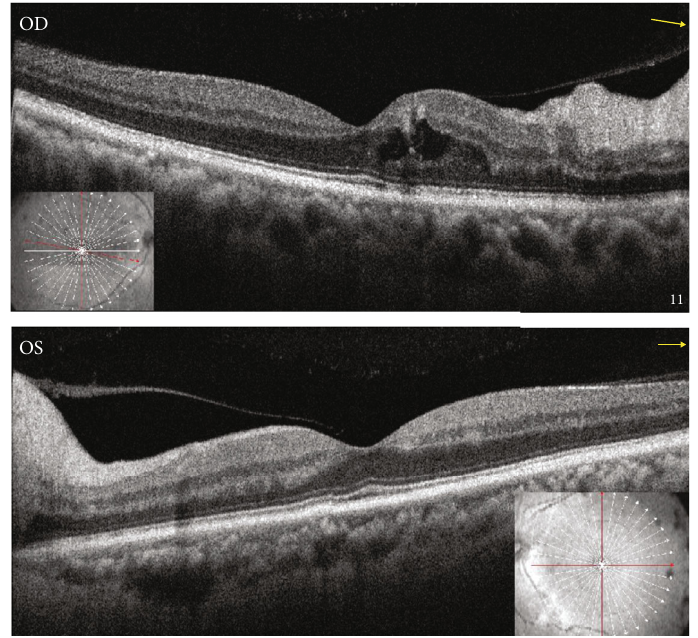
Figure 3: OCT of the right (a) and left (b) maculae showing preserved foveal architecture but distorted and thickened peripapillary nerve fi ber layer, more pronounced in the right eye.